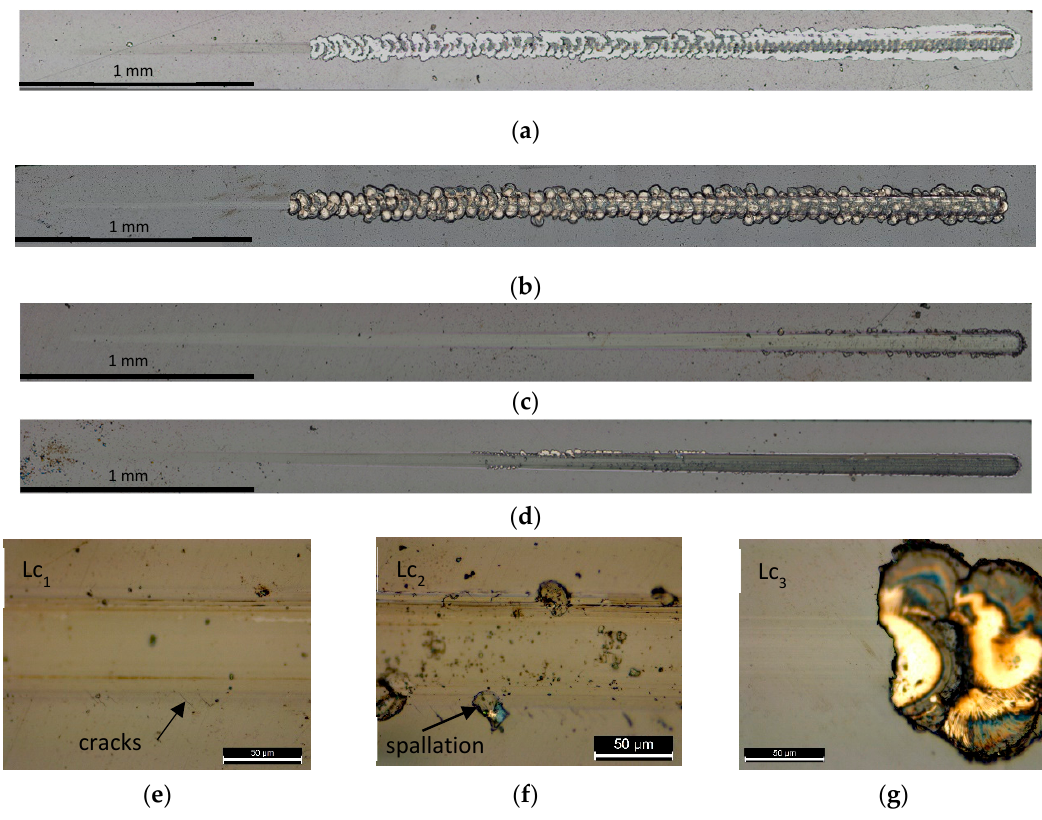
Figure 9. Scratch scars optical micrographs: ( a ) D1-450; ( b ) D2-17; ( c ) D3-17; ( d ) D4-38; ( e ) Lc1 detail acquired from the D3-17 scratch scar; ( f ) Lc2 detail from the D3-13 scar; ( g ) Lc3 detail from the D2-17 scar. Table 2. Mechanical properties and adhesion of the coatings.